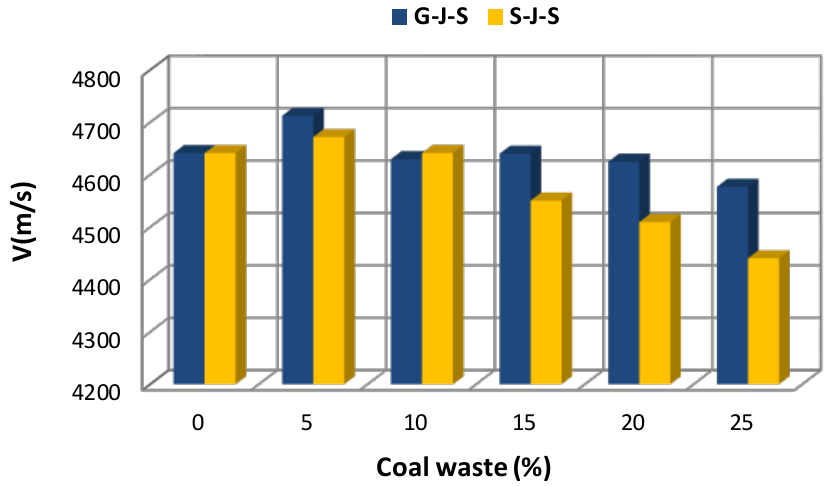
Figure 7. Effect of replacing aggregates with coal waste at the age of 28 days .